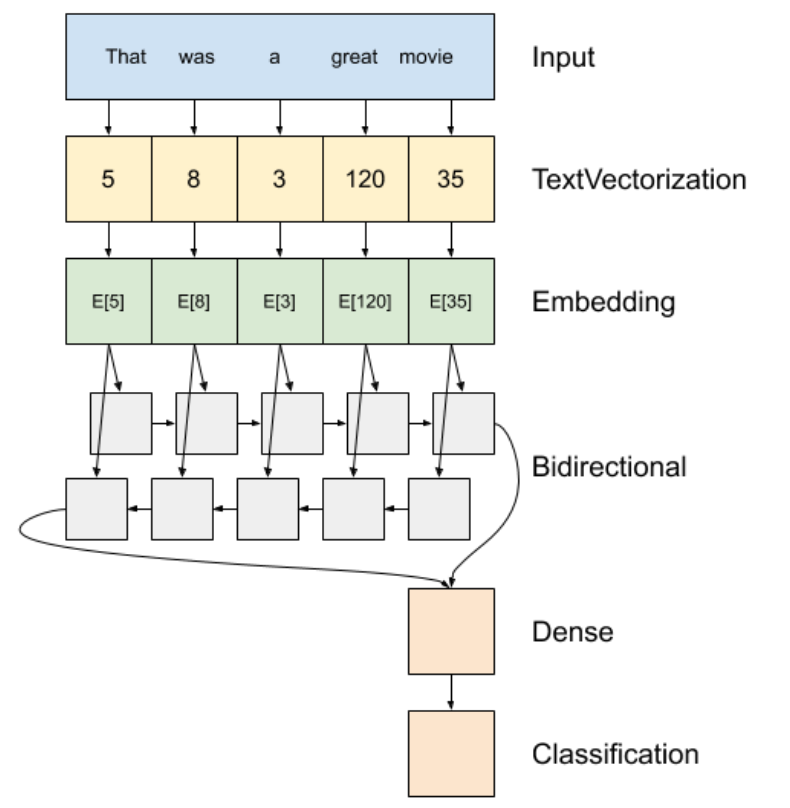
Figure 5. The RNN model has five layers, each of which serves a specific